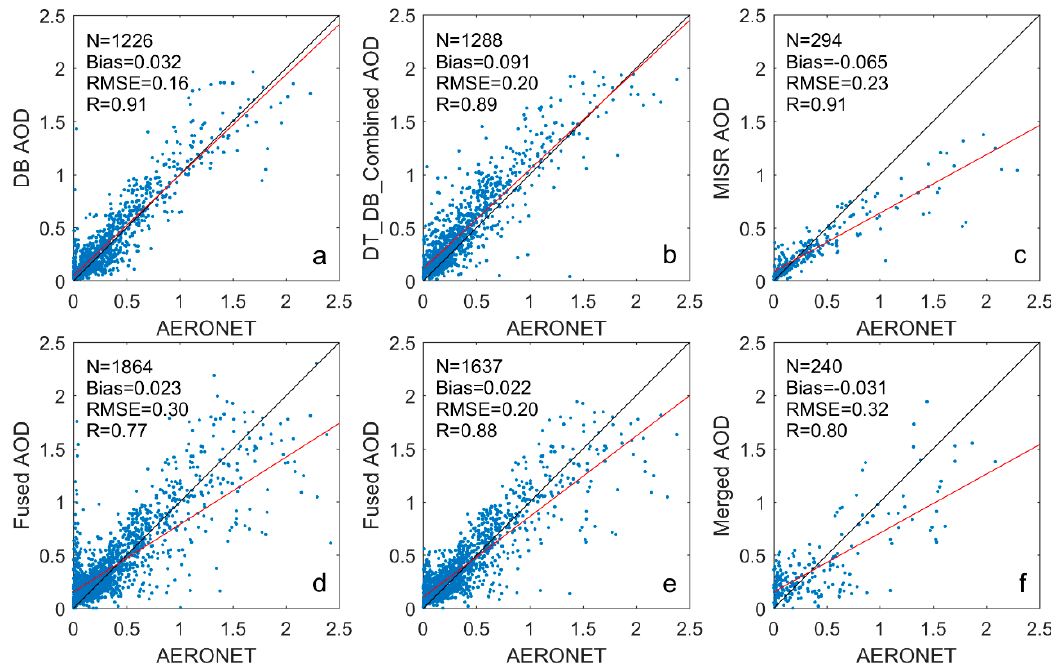
Figure 9. Validations of original satellite AOD products and FRS-EE fused AODs with ground AERONET AOD measurements: ( a ) original DB AOD, ( b ) original DT_DB_Combined AOD, ( c ) original MISR AOD, ( d ) initial FRS fused AOD, ( e ) FRS-EE fused AOD, ( f ) FRS-EE fused AOD in areas without valid satellite retrievals.